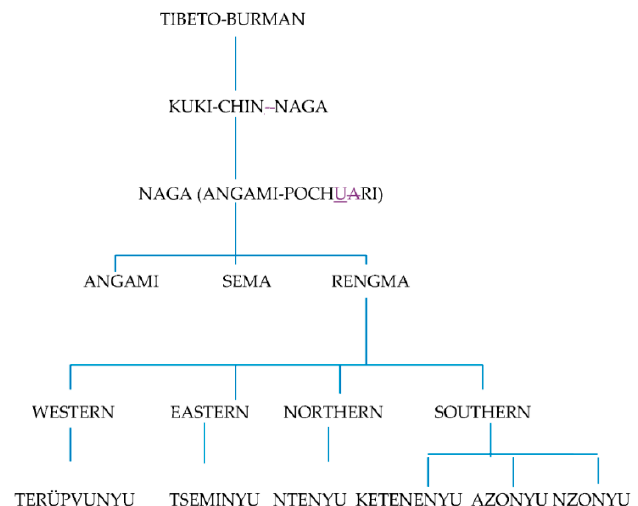
Figure 2. Genetic classification of the Rengma language modified from Ethnologue (Eberhard et al. 2019).